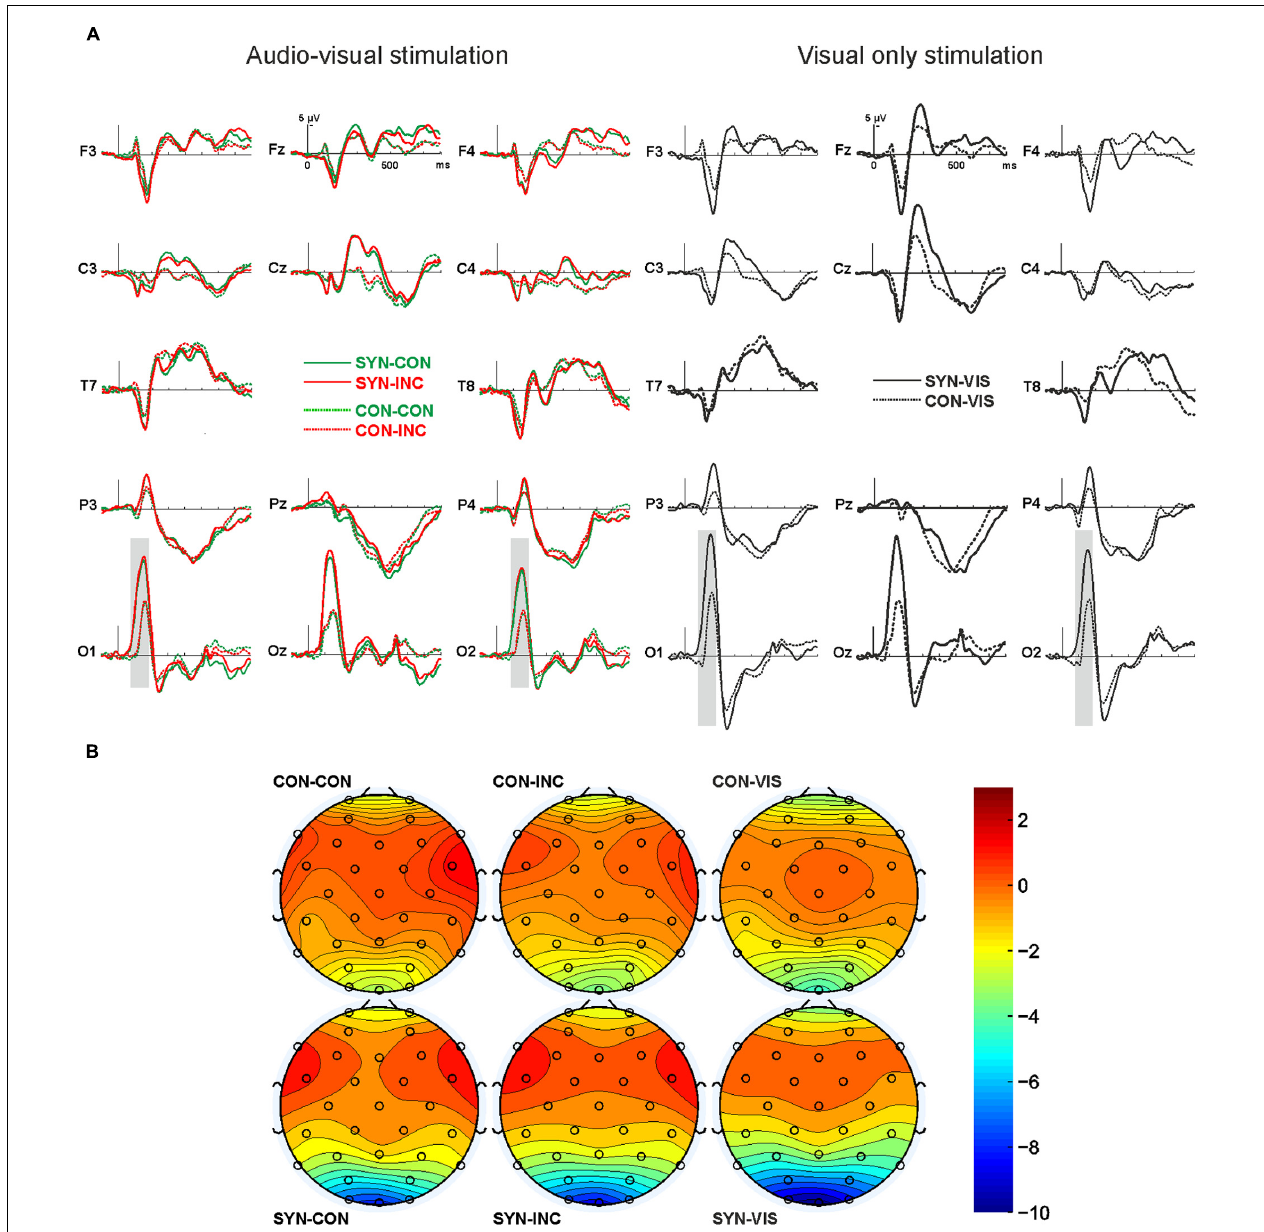
visual only stimulation for synesthesia (continuous line) and control (dotted line) subjects. Electrodes are labeled according to the 10/20 system. Gray bars indicate significant differences. (B) Grand-mean isopotential field map for the time window from 80 to 180 ms, covering the N1